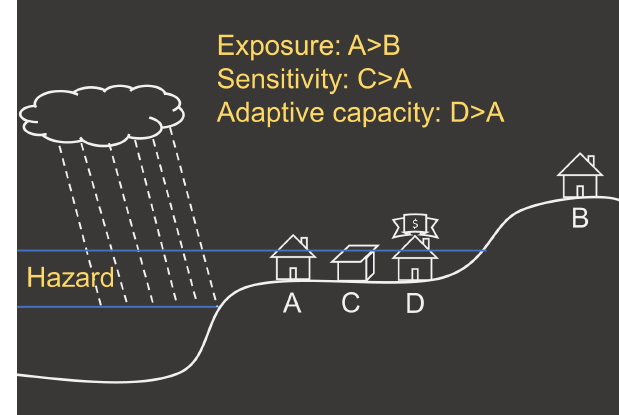
Figure 3. Example of a classroom blackboard used to illustrate the climate risk exercise. Given a flood situation, house A is more ex- posed than house B; the wooden house C is more sensitive than the brick house A; the house with insurance D has a higher adap- tive capacity than a house without insurance. The blue line indicates different flood levels. The definitions of climate hazard, exposure, sensitivity, and adaptive capacity are based on the IPCC climate risk